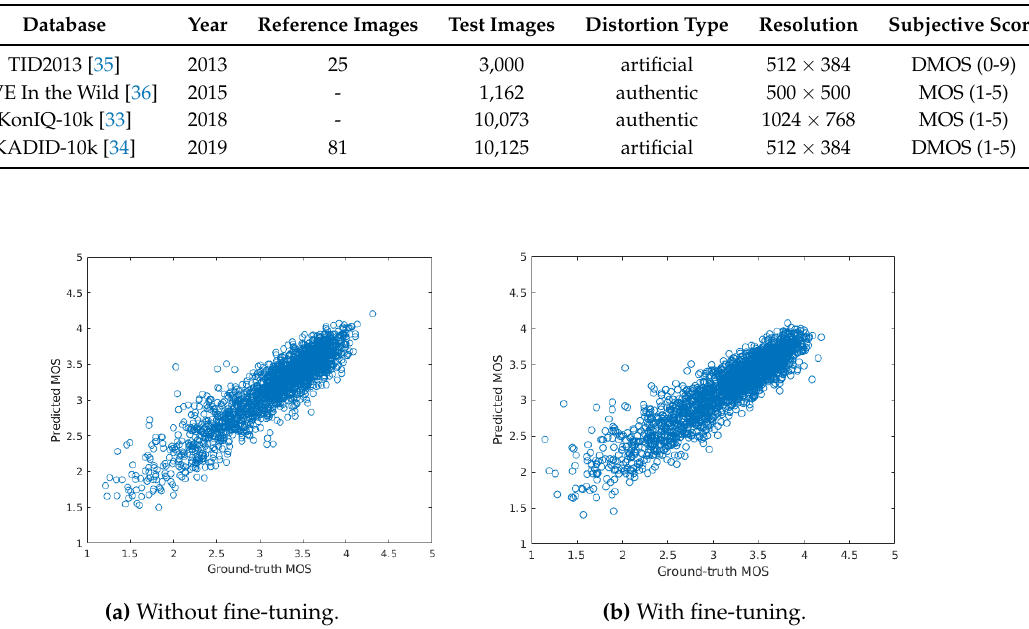
Figure 4. Scatter plots showing the ground-truth MOS values against the predicted MOS values on KonIQ-10k [33] test